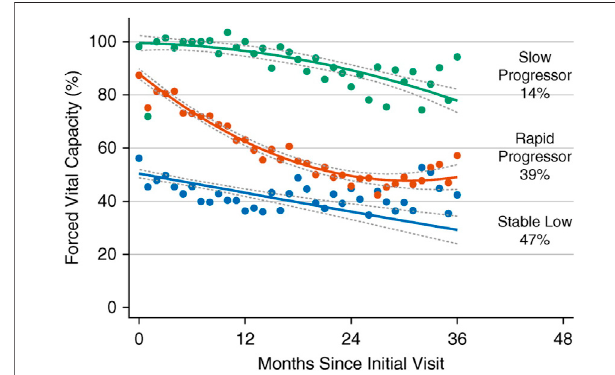
FIGURE 7 | The Penn Comprehensive ALS Center cohort trajectories of forced vital capacity (FVC) percent predicted with 95% con fi dence intervals. Three groups ofpatientswithamyotrophic lateral sclerosis (ALS)areindicated by slow progressors (green), rapid progressors (red), and stable low (blue).Percentagesrepresent proportion ofthecohortwiththecorresponding group number as the highest predicted posterior probability. From (Ackrivo et al., 2019a).